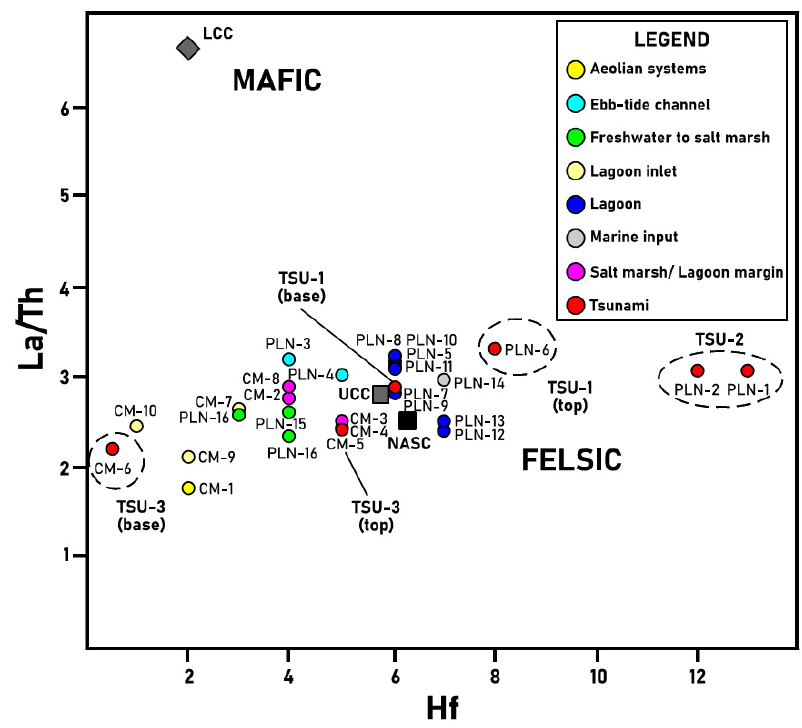
Figure 15. Bivariate plot of Hf-La/Th.